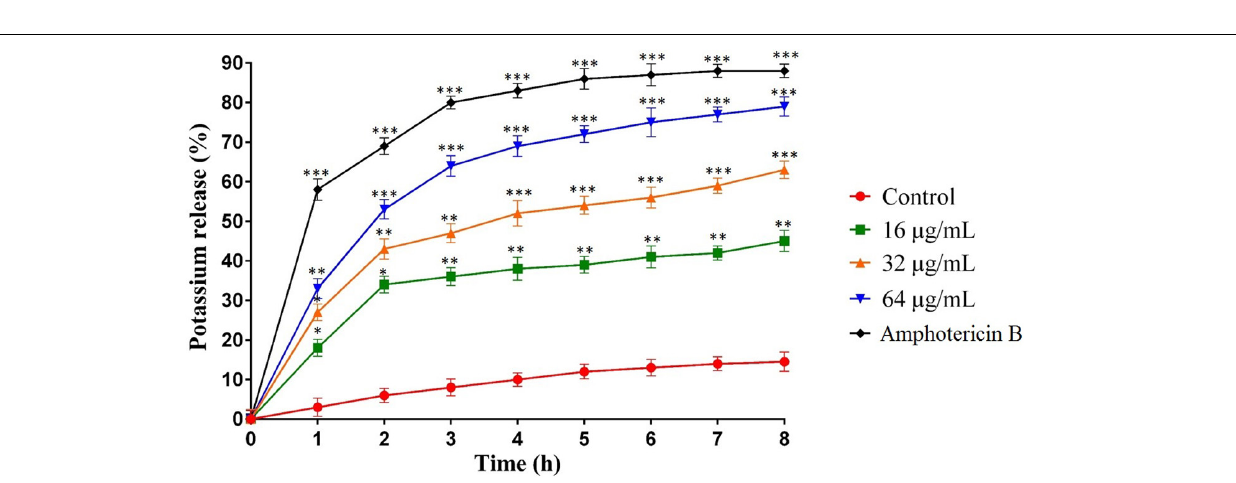
Frontiers in Microbiology |